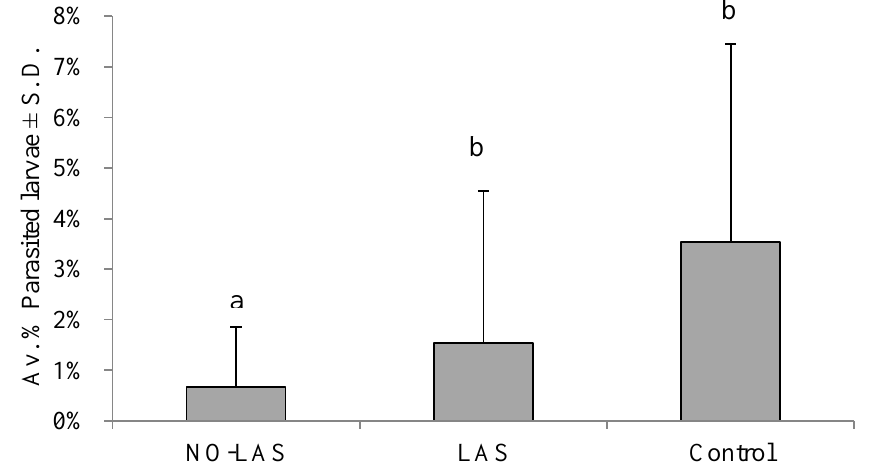
Figure 19. Percentage of parasitism by P. concolor in larvae obtained from infested fruits of NO-LAS, LAS, and control plots. Values followed by the same letter indicate no significant differences among plots (Kolmogorov–Smirnov test, p < 0.05).